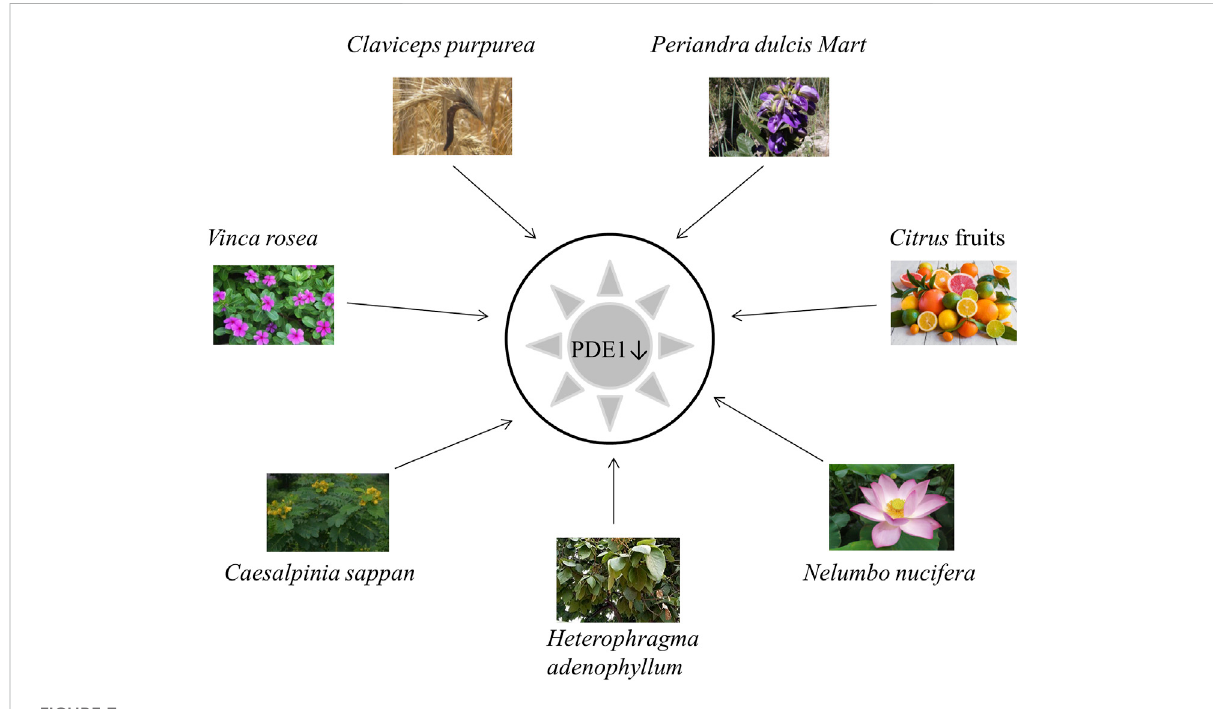
FIGURE 7 Plants inhibiting